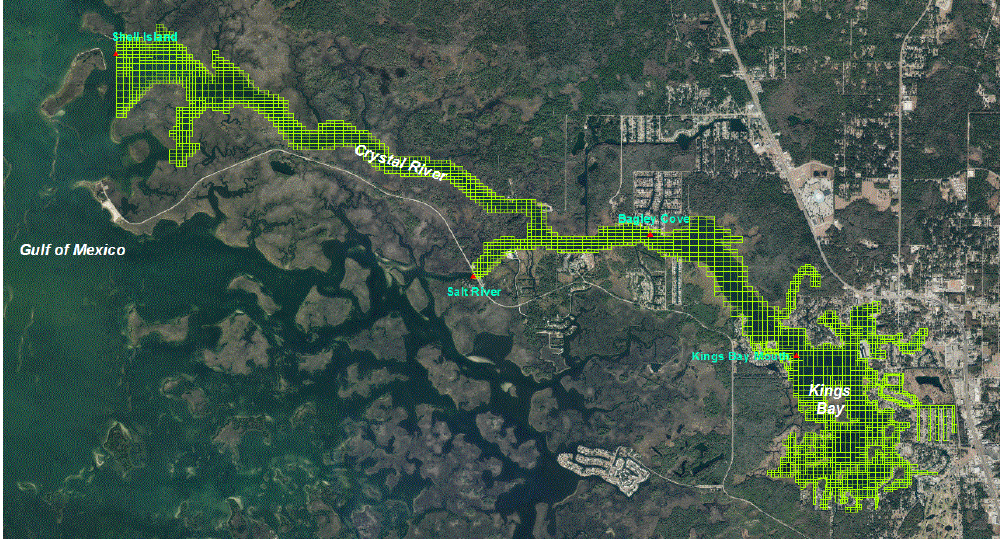
Figure 6. Unstructured Cartesian grid mesh used in the model application to the Crystal River/Kings Bay